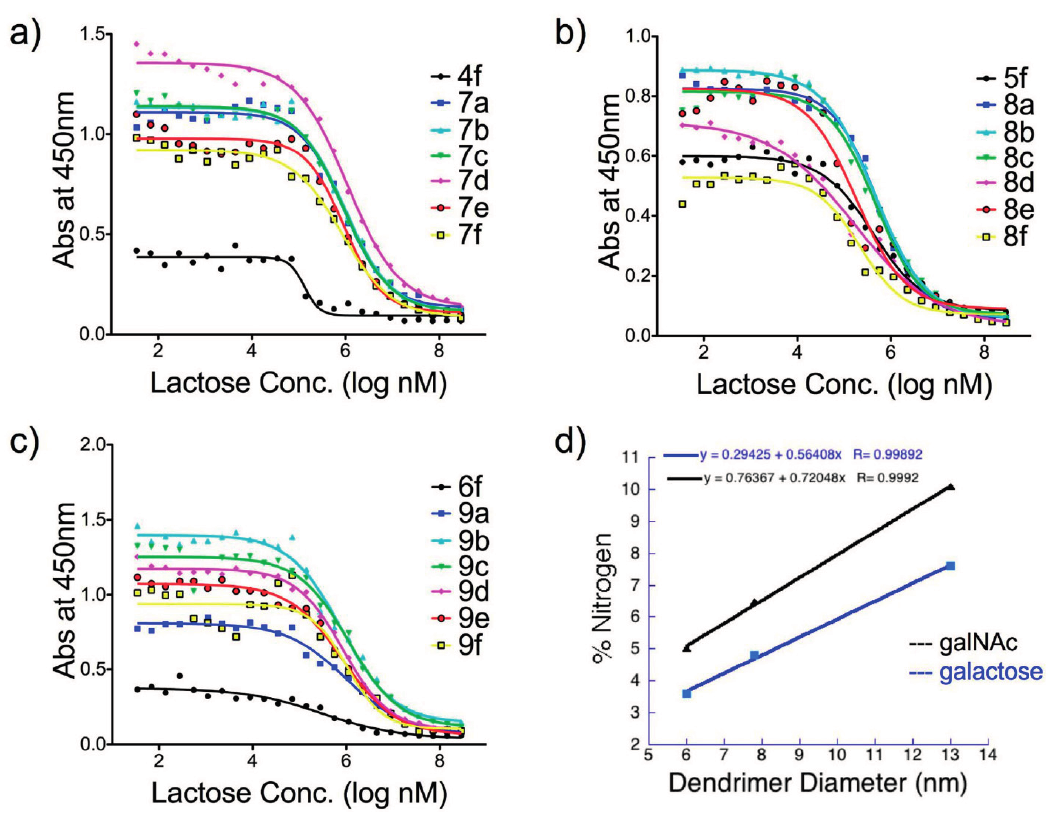
Figure 5. ELISA binding curves with ( a ) 4f , 7a – f ; ( b ) 5f , 8a – f ; ( c ) 6f , 9a – f and ( d ) XPS results of dendrimer diameter vs . nitrogen % for compounds 4f , 5f , 6f and 7f , 8f , 9f